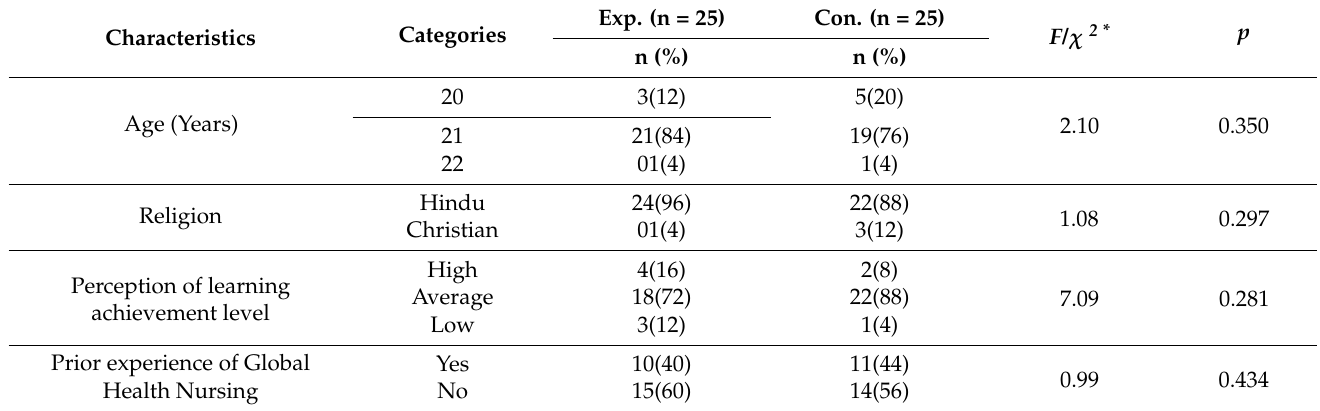
Table 4. The Homogeneity Test of General Characteristics of Nursing Students (N = 50).